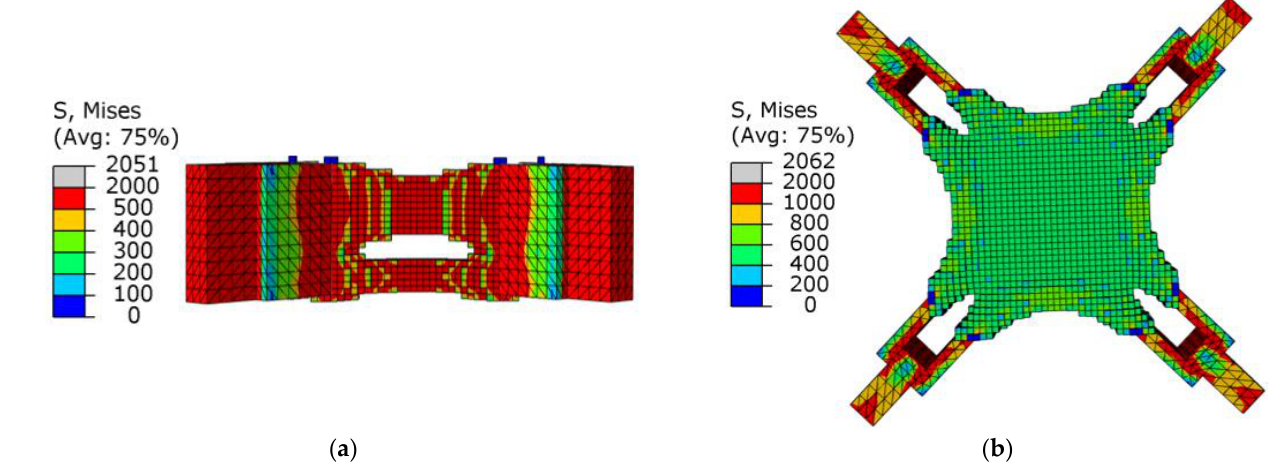
Figure 8. Schematic diagram of optimization results under axial load conditions: ( a ) cutaway view; ( b ) stress nephogram.